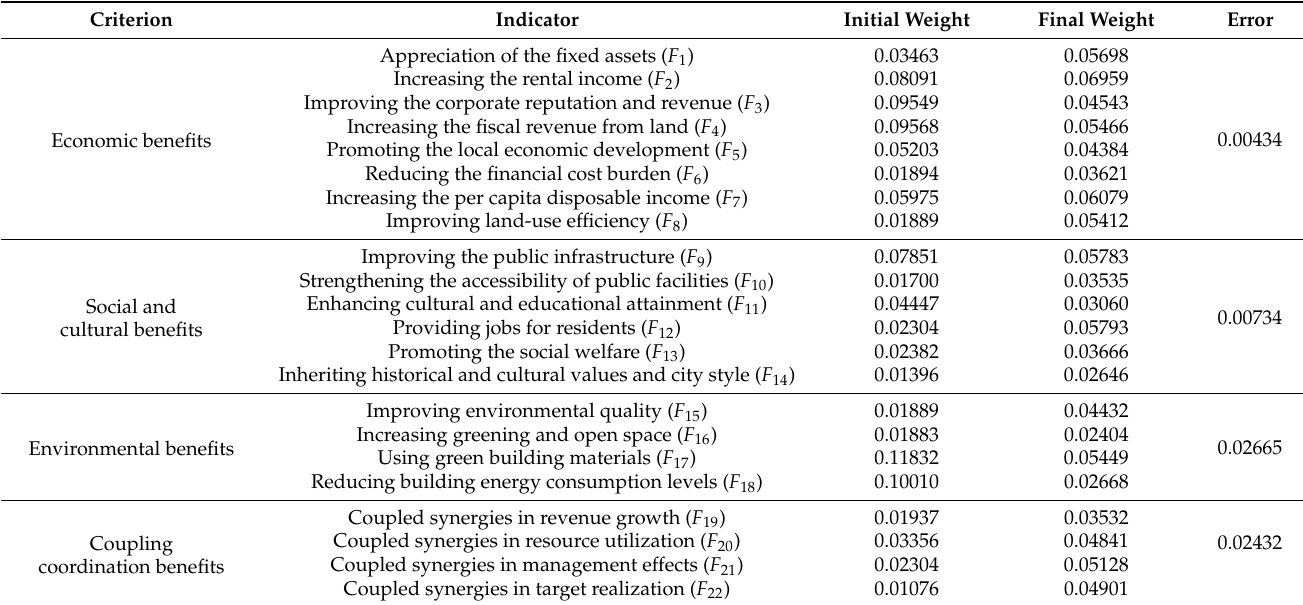
Table 4. The final weights of each indicator.